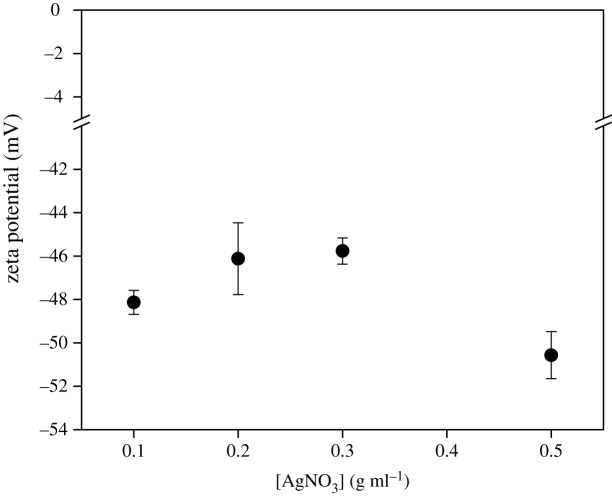
Zeta potential of synthesized AgNPs with different [AgNO3].